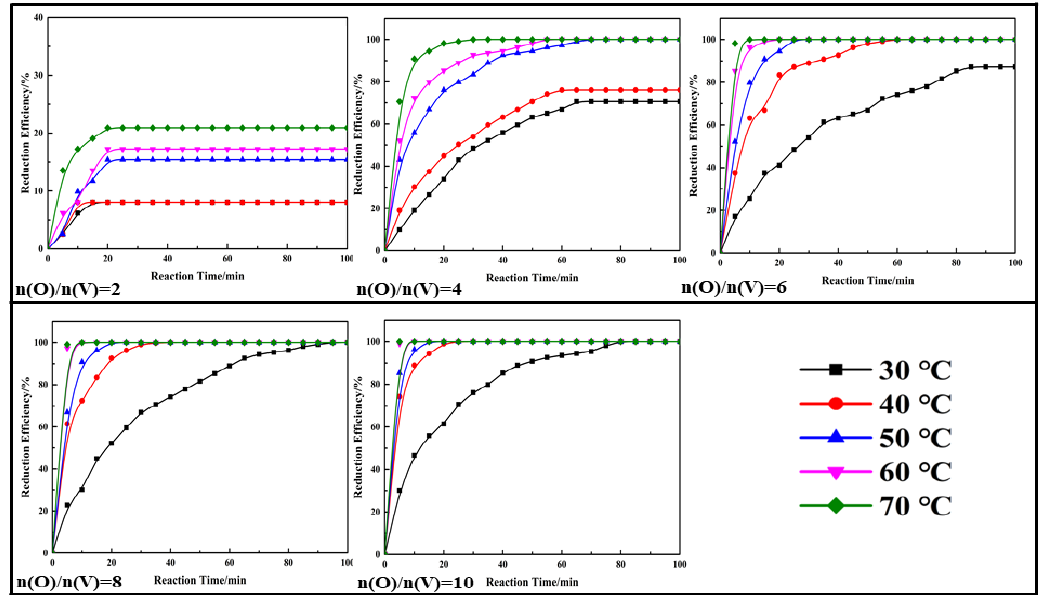
Figure 3. Effect of reaction temperature on the reduction efficiency of vanadium.